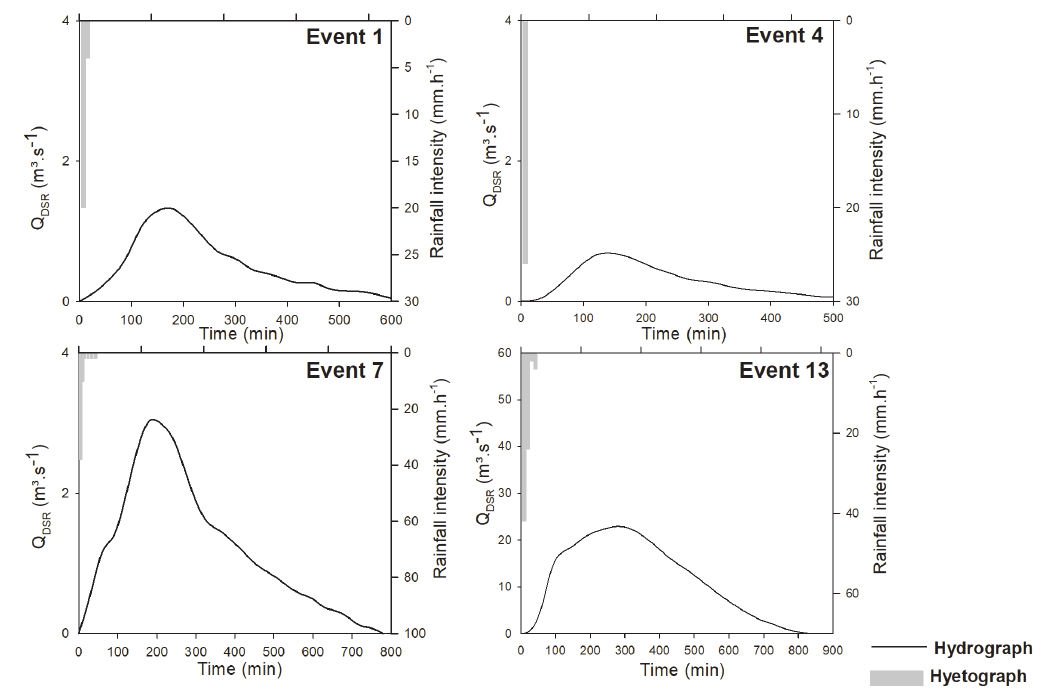
Figure 4 - Illustration of some rainfall-runoff events analyzed in